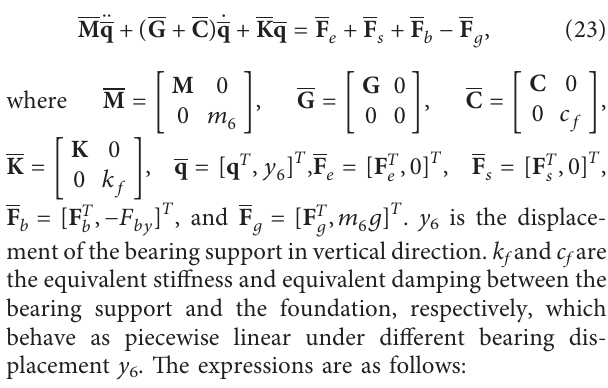
Figure 2: Schematic diagram of loose connecting bolt on bearing pedestal. Table 1: Model parameters of the rotor and the bearing.